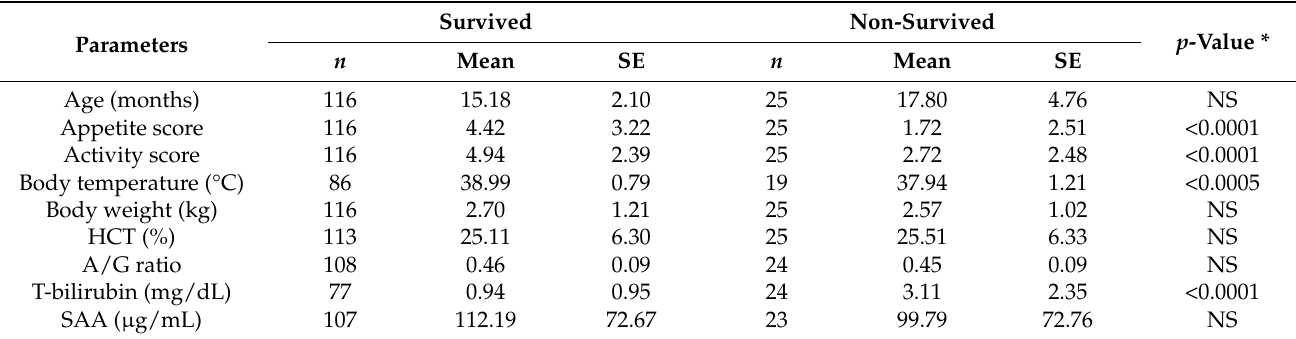
Table 3. Statistical comparison of signalment and clinical parameters between surviving and non-surviving cats with effusive FIP.